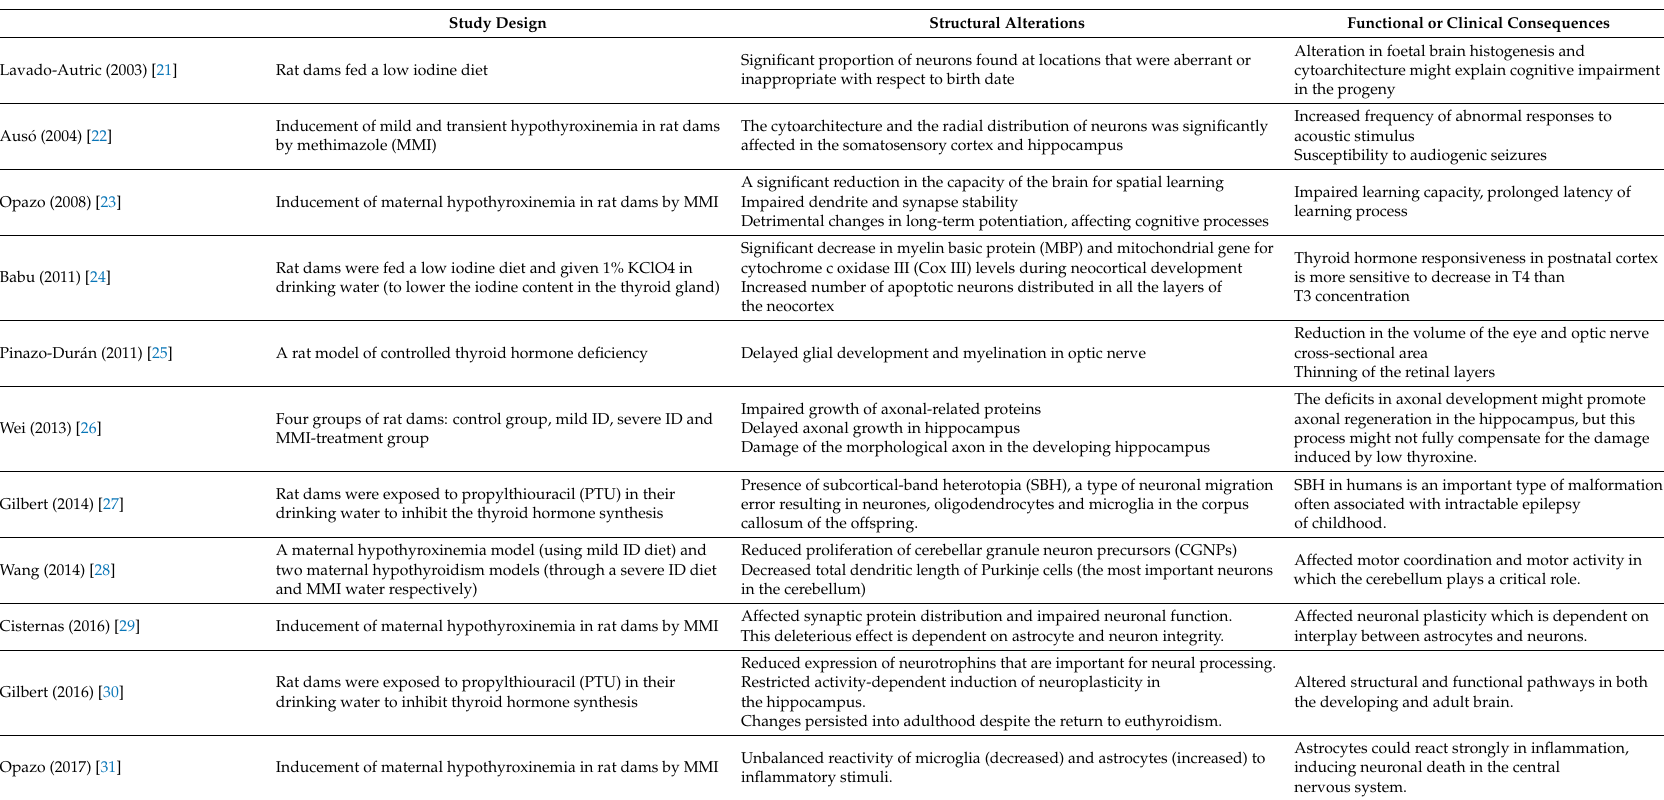
Table 1. Experimental studies demonstrating brain areas affected by maternal